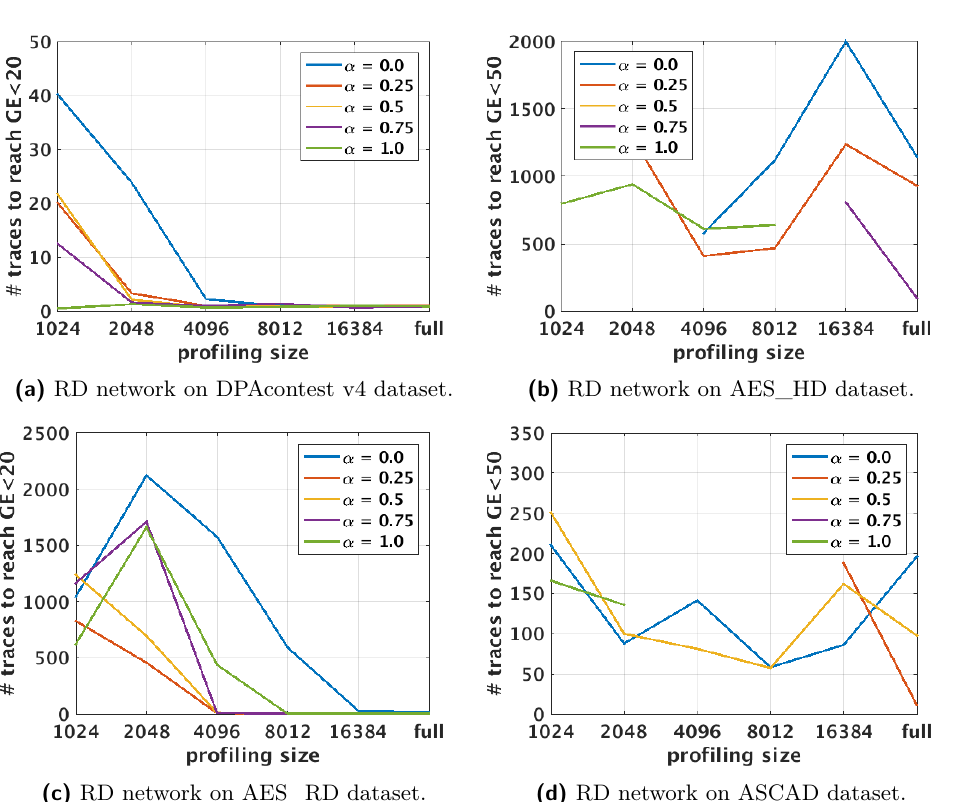
Figure 12: Guessing entropy results for different levels of noise and number of profiling